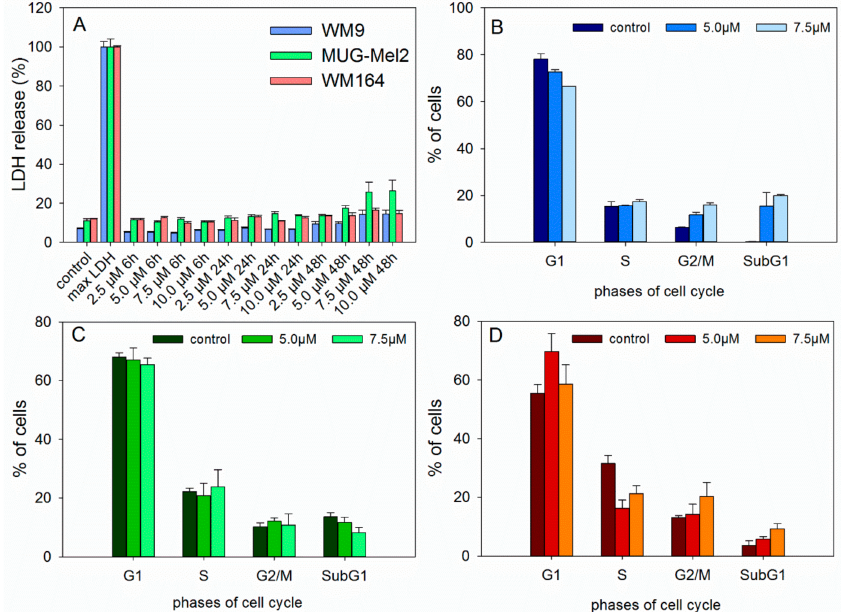
Figure 4. ( A ) Results of lactate dehydrogenase (LDH) assay showing that 6 caused no significant damage to the cell membrane in different melanoma cells (mean ± SEM, n = 6). Maximum LDH release control was used to determine maximal LDH release. ( B – D ) Treatment of melanoma cells with 6 did not lead to significant changes in the cell cycle distribution (B: WM9, C: MUG-Mel2, and D: WM164 cells, 24 h of incubation, mean ± SEM, n =